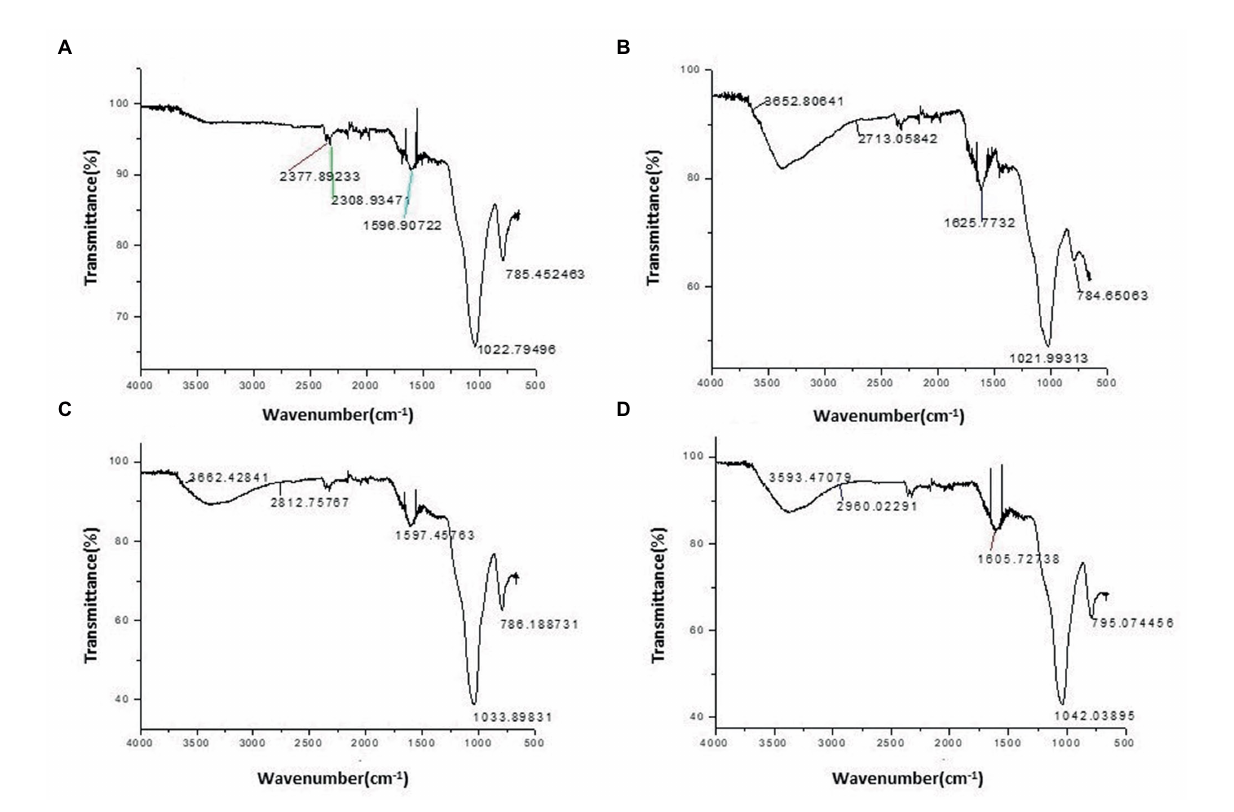
FIGURE 1 Fourier-Transform Infrared (FTIR) characterization of (A) Simple rice husk biochar (SBc), (B) iron biochar (FeBc), (C) Zinc biochar (ZnBc), and (D) Manganese biochar